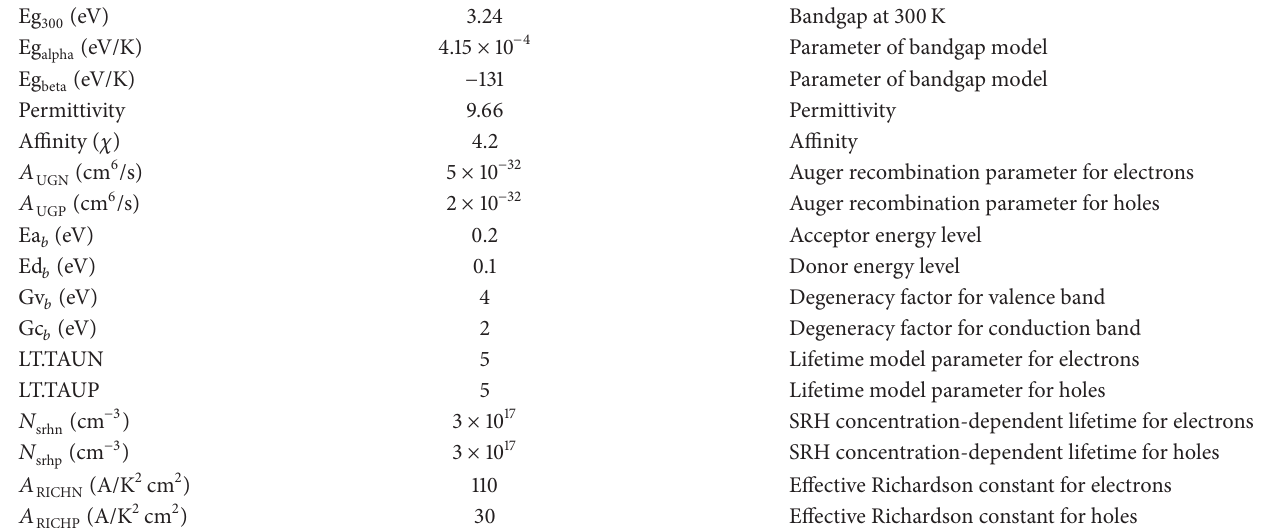
Table 2: Parameters used in 4H-SiC based MOSFET device